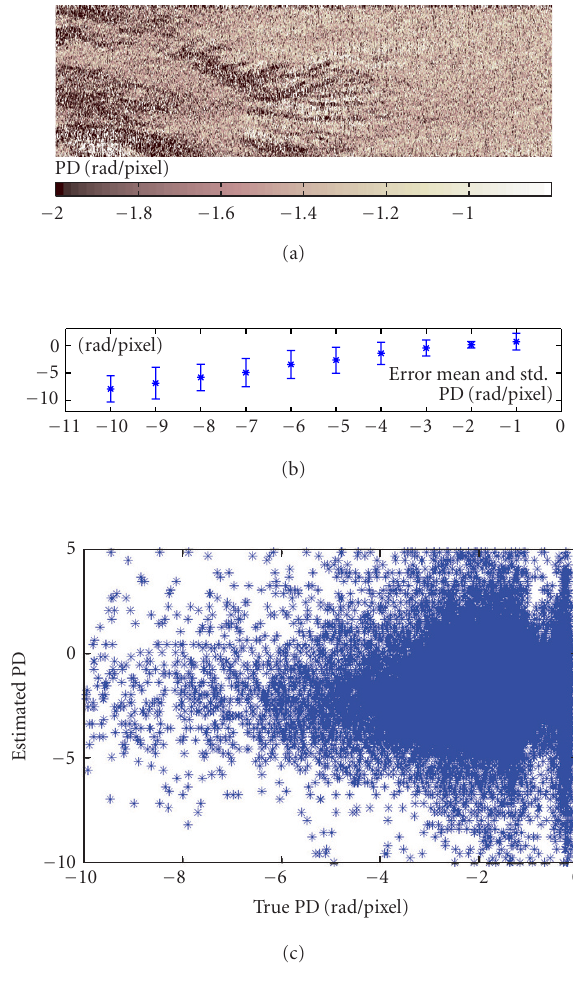
Figure 7: (a) PD estimated with the lowest baseline interferograms, (b) error plot (mean and standard deviation of the error), and (c) the scatter plot of the estimated PD versus the true PD.